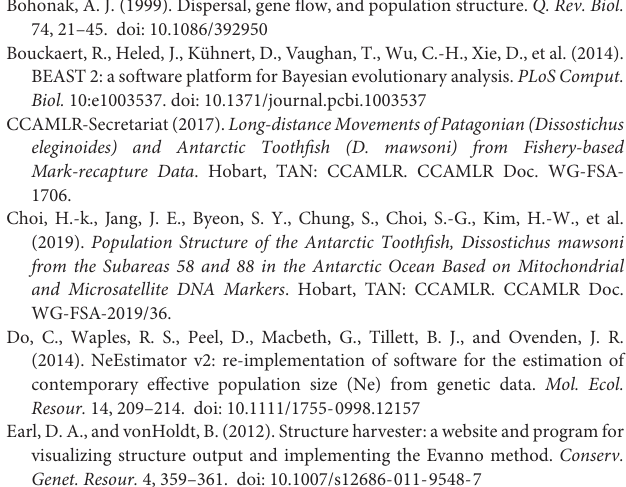
Supplementary Figure 6 | Population structure based on a Bayesian population assignment between juveniles and adults of Dissostichus mawsoni from the 10 populations (Subareas 88: 88.1 RBI, 88.2 RB1, 88.3 RB1, 88.3 RB3, 88.3 RB4, 88.3 RB5, and 88.3 RB6; Subareas 58: 58.4.1 A, 58.4.2 A, and 58.4.2 E) using seven microsatellite loci. Each individual is represented along the X -axis, and the Y -axis denotes the probability of that individual belonging to each of the genetic clusters. (A) Analyses of population structure for the two groups combined; (B) The most likely number of genetic clusters after Delta K Evanno’s correction corresponds to K = 1. Supplementary Figure 7 | Mitochondrial and microsatellite phylogenetic relationships of Dissostichus mawsoni from CCAMLR. The phylogenetic trees were constructed from mtDNA COI and 16S haplotypes based on a maximum parsimony (MP) method including two Subareas 58 and 88 (A) and from seven microsatellite loci using the genetic distance ( F ST ) based on neighbor joining (NJ) method (B) . Numbers at branches indicate the bootstrap values MP and NJ, respectively. Hap1 , 2 , 3 , 6 , 8 , 9 represent shared haplotypes between Subareas 58 and 88 (A) . Supplementary Table 1 | Comparisons of genetic diversity indices between juveniles and adults of Dissostichus mawsoni from 10 populations (Subareas 88: 88.1 RBI, 88.2 RB1, 88.3 RB1, 88.3 RB3, 88.3 RB4, 88.3 RB5, and 88.3 RB6; Subareas 58: 58.4.1 A, 58.4.2 A, and 58.4.2 E) at mtDNA (COI and 16S) and seven microsatellite loci. N: number of samples analyzed, N H : number of haplotypes, h : haplotype diversity, π : nucleotide diversity, N A : observed mean number of alleles across seven loci, N E : effective population size, PA: number of private alleles, H E : expected heterozygosity, H O : observed heterozygosity, F IS : inbreeding coefficient, HWE: P values for multilocus tests for Hardy-Weinberg Equilibrium. Supplementary Table 2 | Pairwise genetic differentiation ( F ST ) based on mtDNA COI and 16S sequences (below diagonal) and seven microsatellites loci genotypes (above diagonal) between juveniles and adults of Dissostichus mawsoni from 10 populations (Subareas 88: 88.1 RBI, 88.2 RB1, 88.3 RB1, 88.3 RB3, 88.3 RB4, 88.3 RB5, and 88.3 RB6; Subareas 58: 58.4.1 A, 58.4.2 A, and 58.4.2 E). Sampling localities and sample sizes of the 10 populations for juveniles and adults are given as in Supplementary Table 1 . Significant pairwise F ST and P values are bolded ( P < 0.05). Supplementary Table 3 | Distribution of forty haplotypes (COI: 14, 16S: 28) found in 392 individuals of Dissostichus mawsoni collected from the 20 research blocks in two CCAMLR Subareas (Subareas 58 and